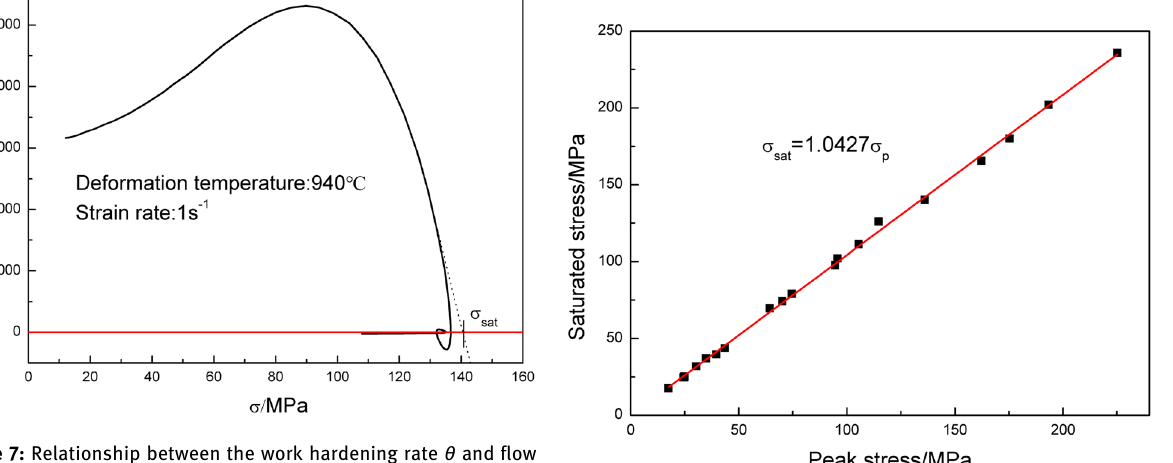
Figure 7: Relationship between the work hardening rate θ and fl ow stress σ at certain deformation condition and determination of σ sat value on the θ – σ curve. Figure 8: Relationship between σ sat and σ p